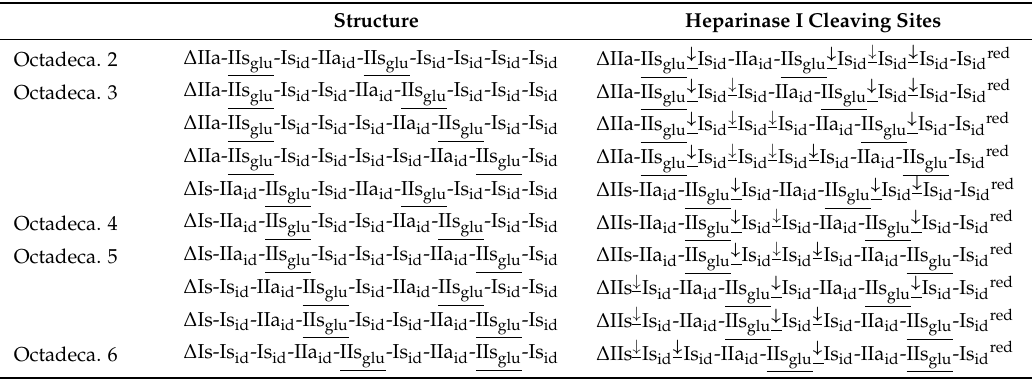
Table 2. Heparinase 1 cleaving sites ( ↓ major sites; ↓ minor